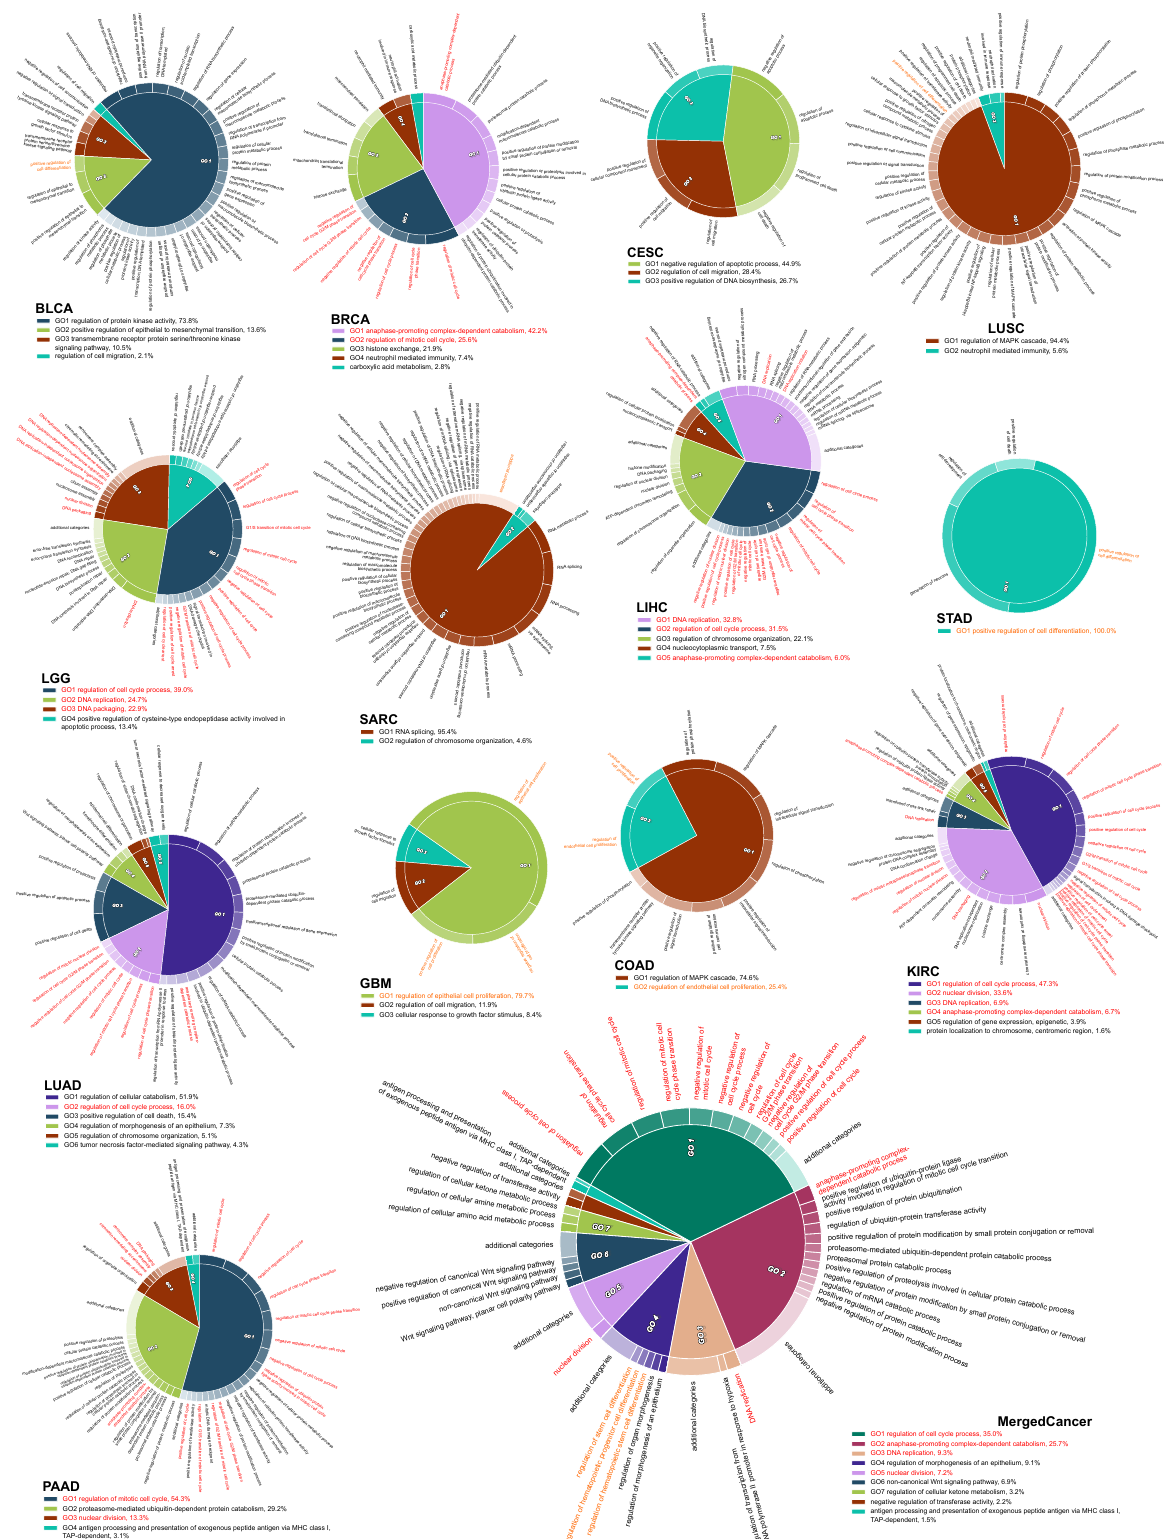
Figure 4. The survival influential modules formed by harmful SIGs. Each pie chart shows the identified functional modules in which the harmful SIGs are involved in the corresponding cancer type. The percentage is the relative significance of one functional module to the others. The functional modules associated with cell cycle are marked by red; modules related to cell proliferation or differentiation are marked by